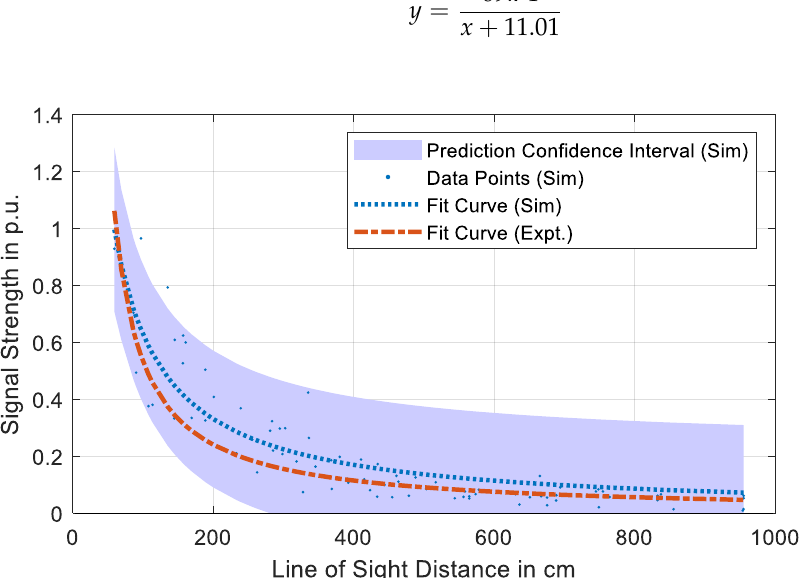
Figure 12. Signal attenuation in the simulation model of transformer A with corresponding fit curve and comparison with the fit curve obtained from experimental data.